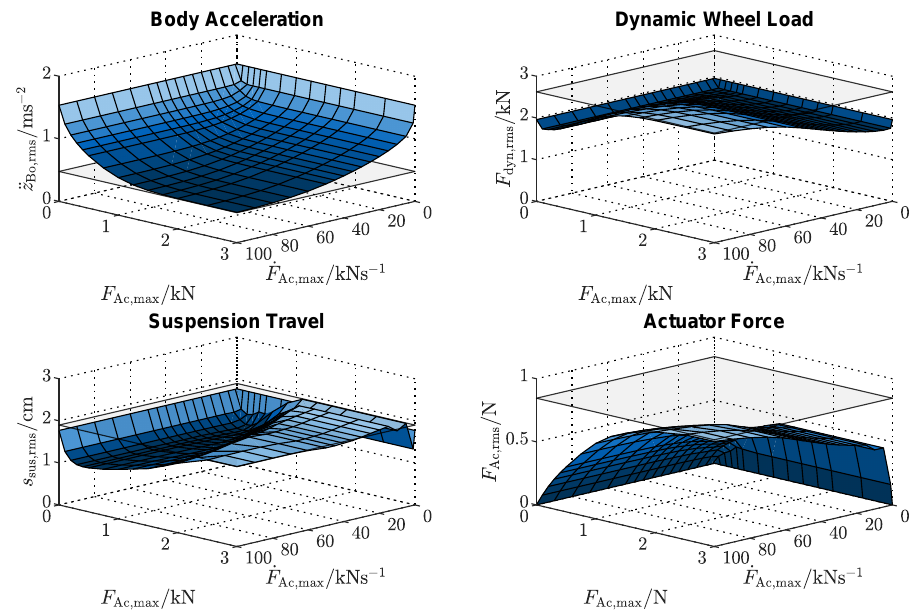
Figure 14. RMS surface plots for the 180kmh − 1 AB profile scenario.